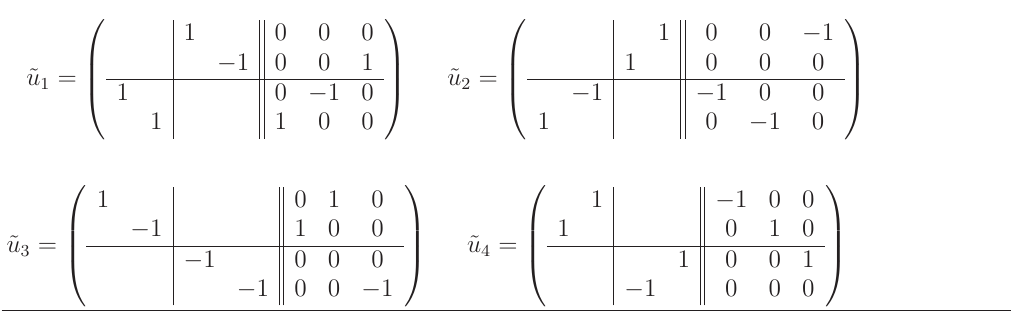
Table 6: The four “up” linkage matrices associated with the Maxwell field-strength multiplet.